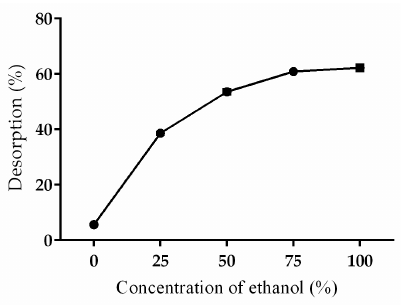
Figure 3. The effects of ethanol concentration on the